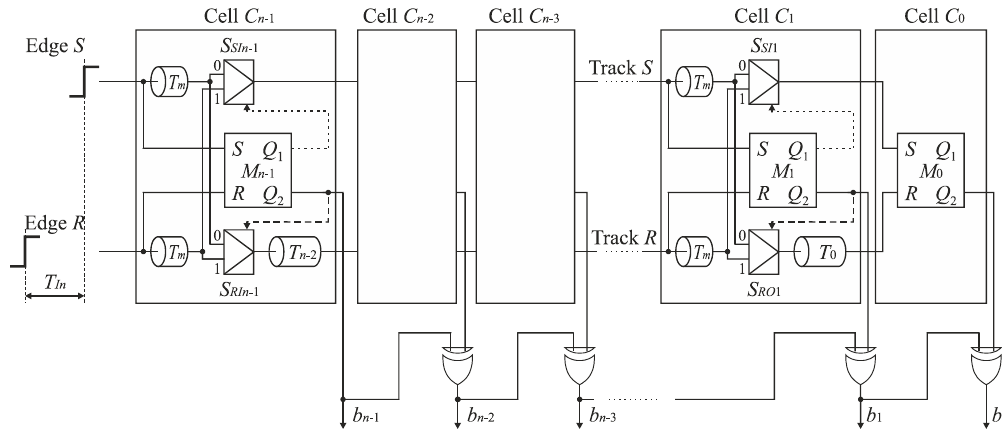
Figure 20. Architecture of n -bit feedforward SA-TDC with single set of delay lines and compensation of logic propagation delays.